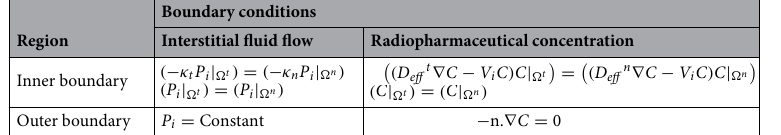
Table 3. Boundary conditions employed in computational